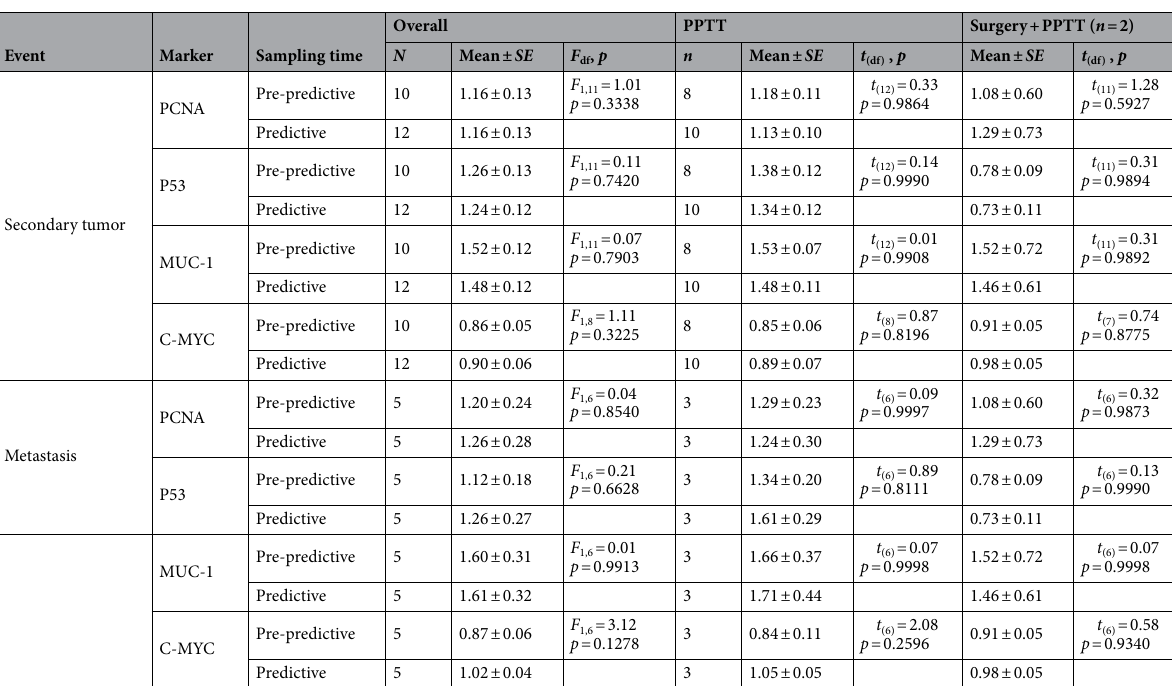
Table 5. Comparison between AAbs values measured just before the appearance of secondary tumors and metastasis (predictive), and last values measured before the predictive values (pre-predictive). The overall values were calculated regardless of treatments. Significant results at p < 0.05 if